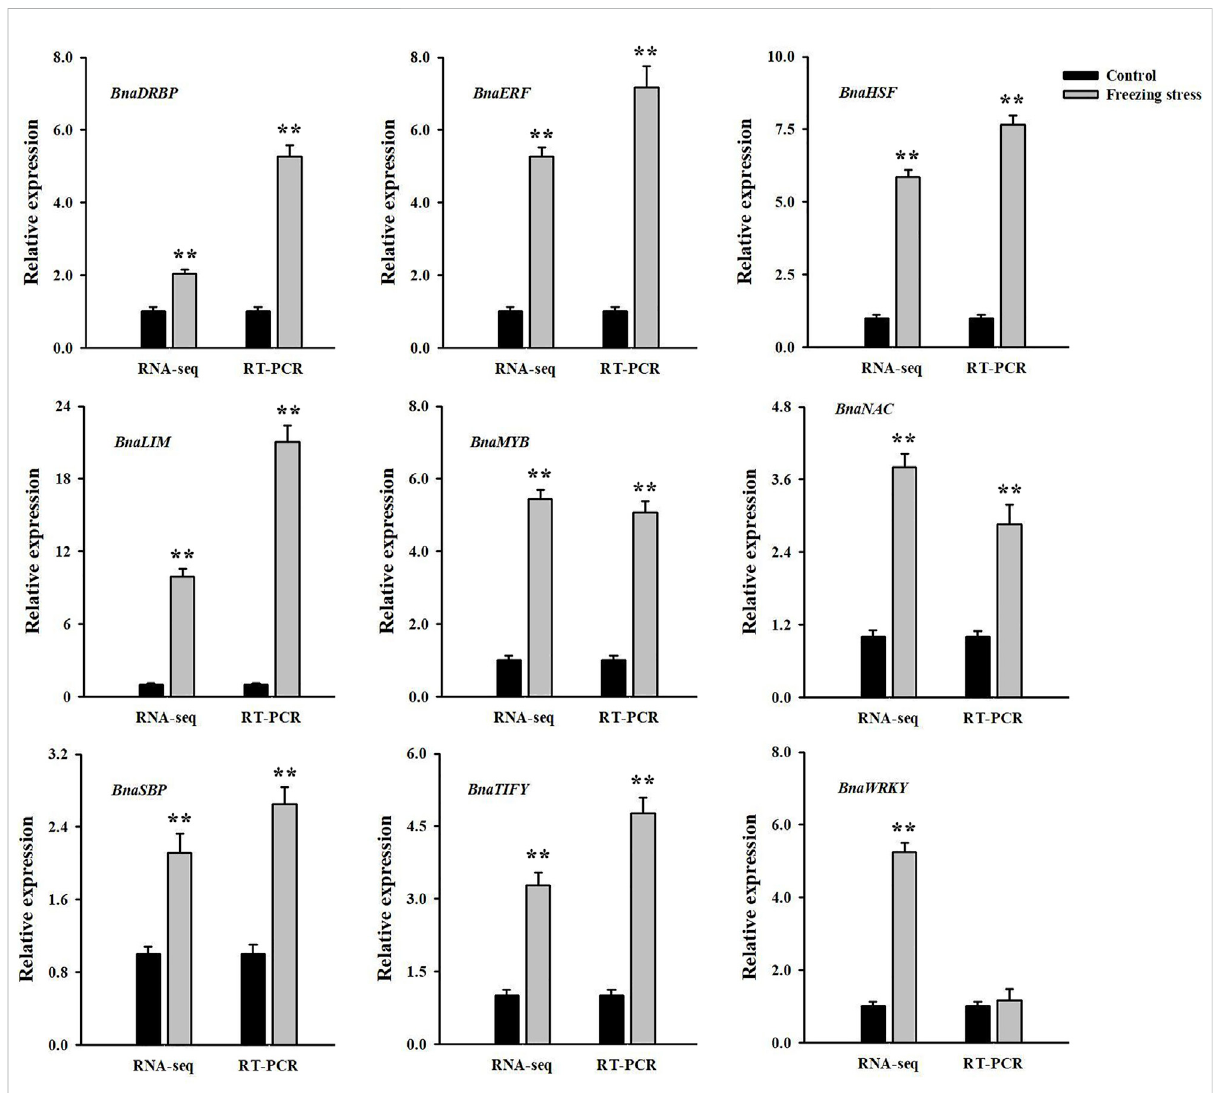
FIGURE 7 Comparative analysis of mRNA and RNA-seq levels in winter rapeseed NS under freezing stress. Values are means ± SD from three biological replicates in winter rapeseed 17NS under freezing